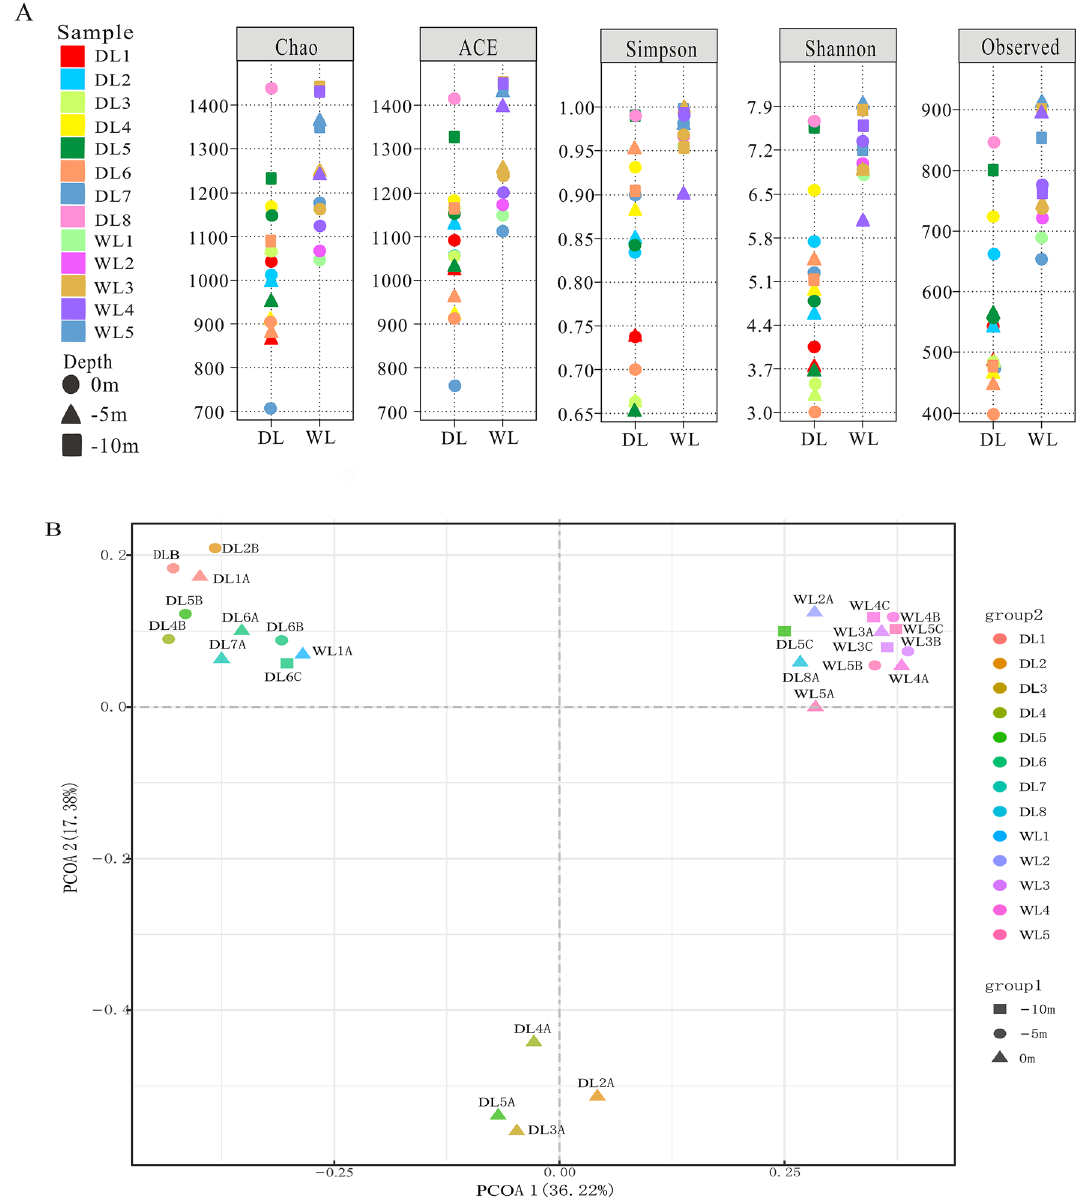
Figure 4. Alpha diversity of bacterioplankton communities from WL Reservoir and DL Reservoir ( A ) and PCoA plots representing bacterioplankton community dissimilarity of all samples based on the Bray–Curtis distances ( B